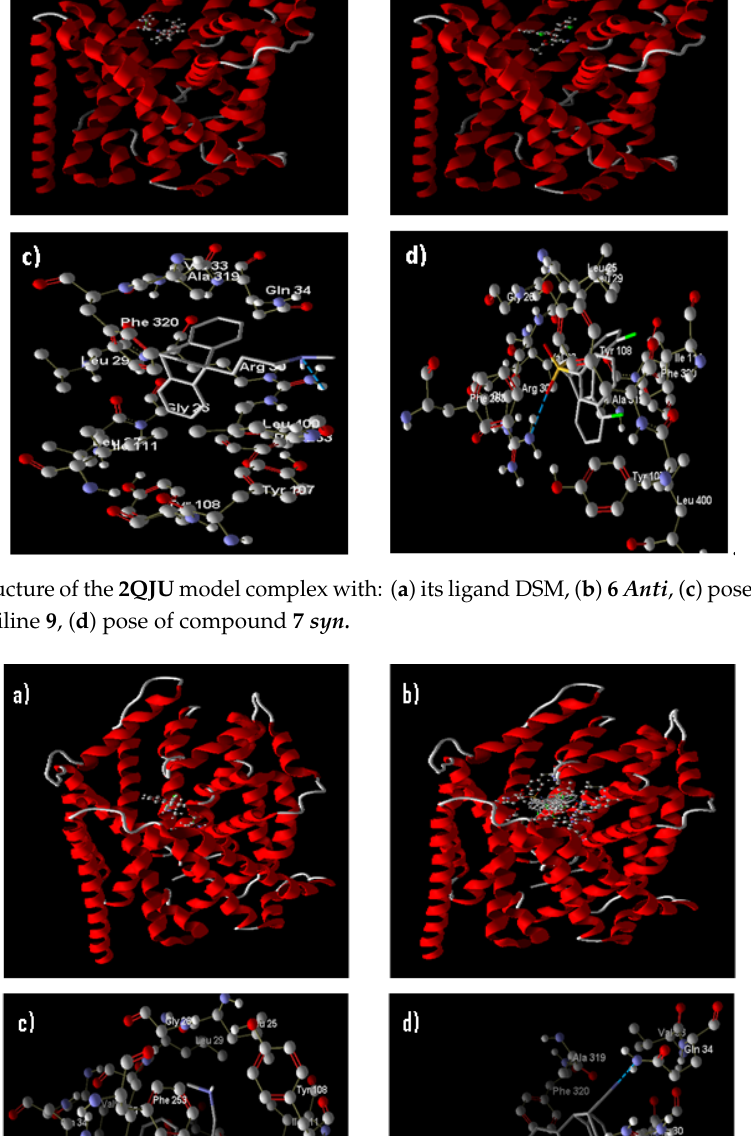
Figure 3. Structure of the 3GWU model complex with: ( a ) its ligand sertraline, ( b ) all docked compounds (5–7) anti and (5–7) syn , ( c ) Pose of maprotiline 9 as reference drug, ( d ) Pose of compound 5 anti .